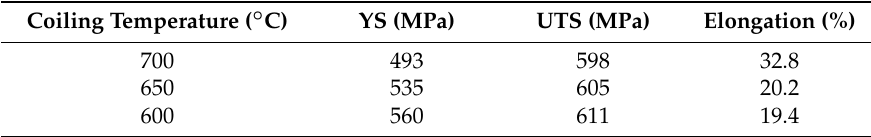
Table 2. Mechanical properties of experimental steel coiled at different temperatures.